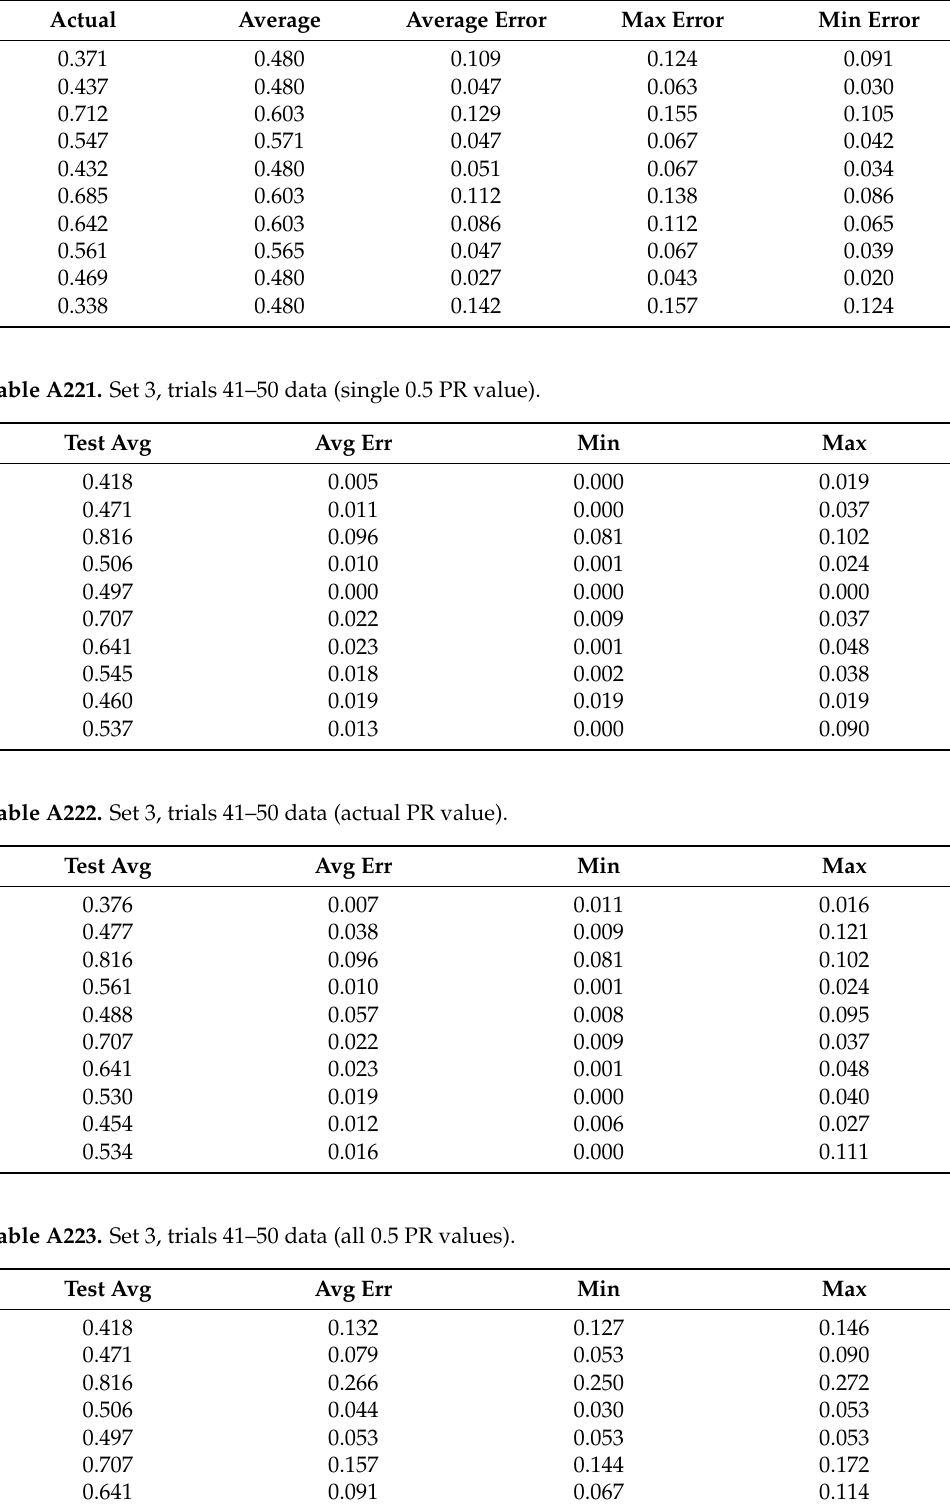
Table A220. Set 3, trials 41–50 data (average actual PR values).